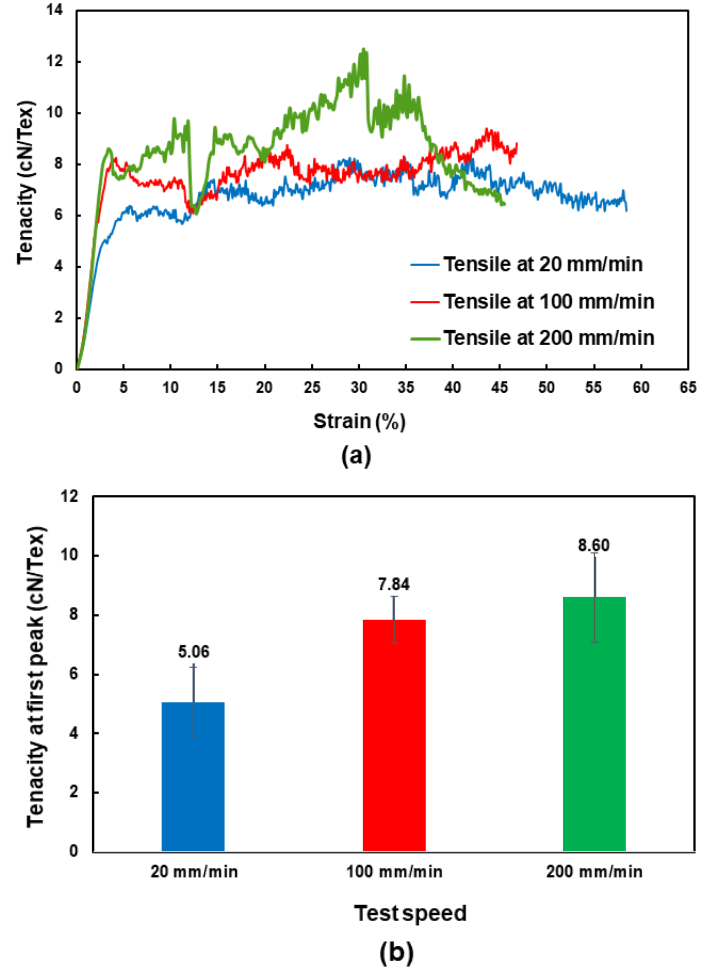
Figure 6. ( a ) Tenacity–strain curve of hybrid yarns at different test speeds; ( b ) tenacity at first peak at different test speeds.